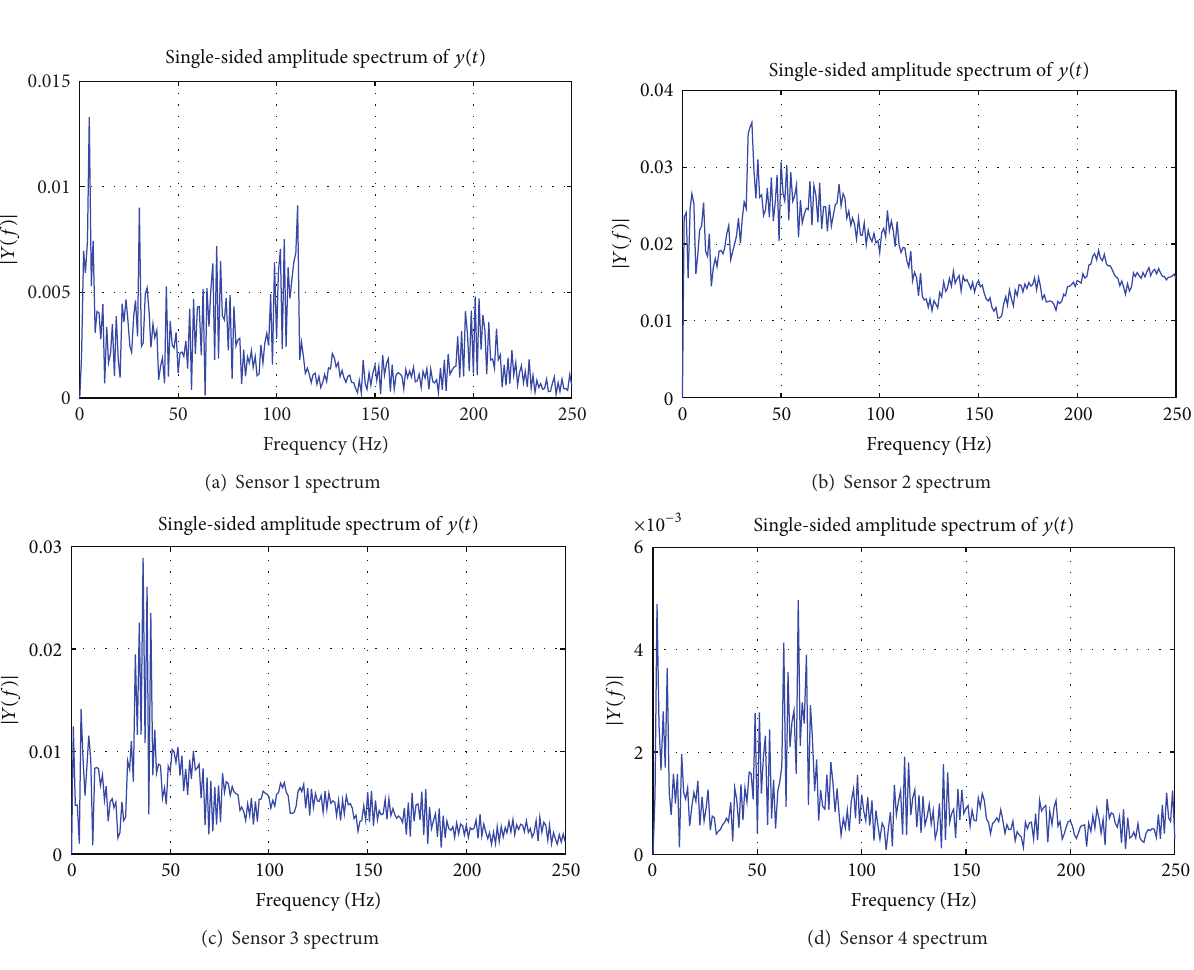
Figure 9: Sensors spectrum of the landing mechanism with 𝑉 𝑦 = 0.41 m/s, 𝑉 𝑥 = 0 m/s, and 𝜃 = 10 ∘